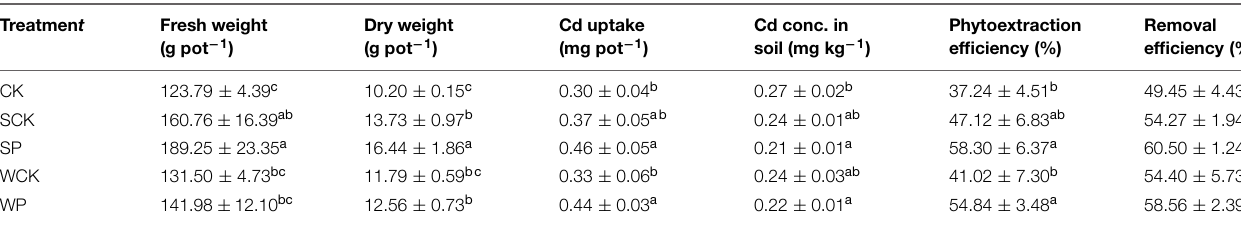
TABLE 2 | Effect of inoculation agents on shoot biomass and Cd uptake of Sedum plumbizincicola and